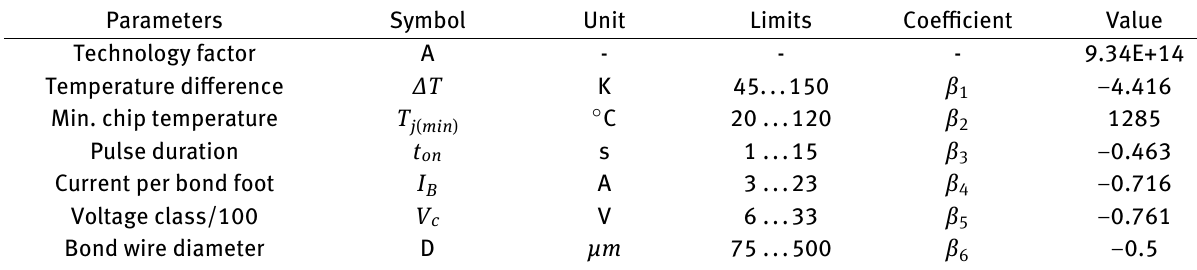
Table 6: Parameters and limits for the calculation of power cycles using equation in (18) Parameters Symbol Unit Limits